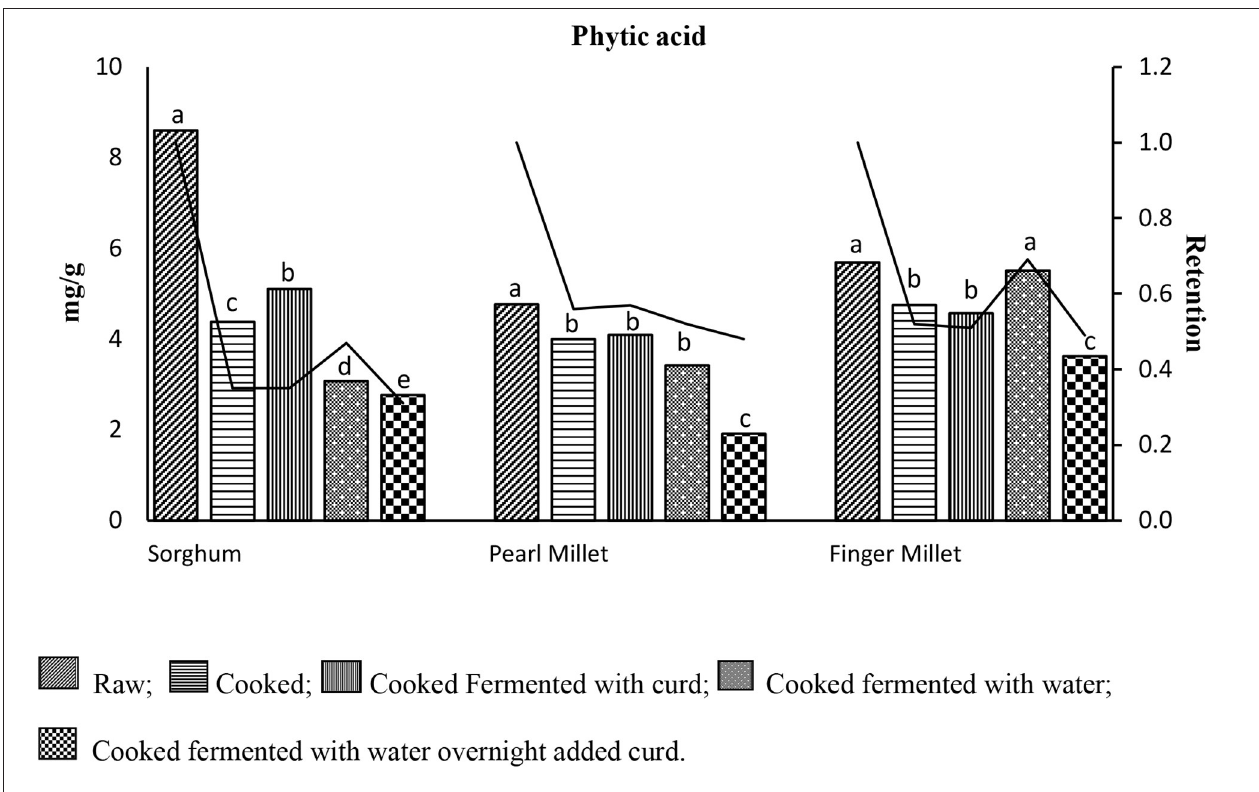
FIGURE 3 | Phytic acid content and its retention in raw and traditionally cooked